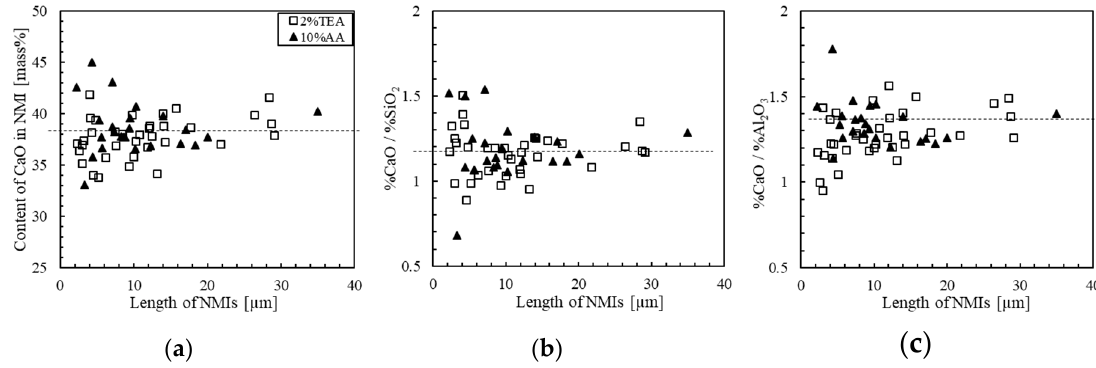
Figure 3. CaO contents ( a ) and ratios of %CaO/%SiO 2 ( b ) and %CaO/%Al 2 O 3 ( c ) in oxide inclusions in 316Ca samples after extraction by using 2% TEA and 10% AA electrolytes.